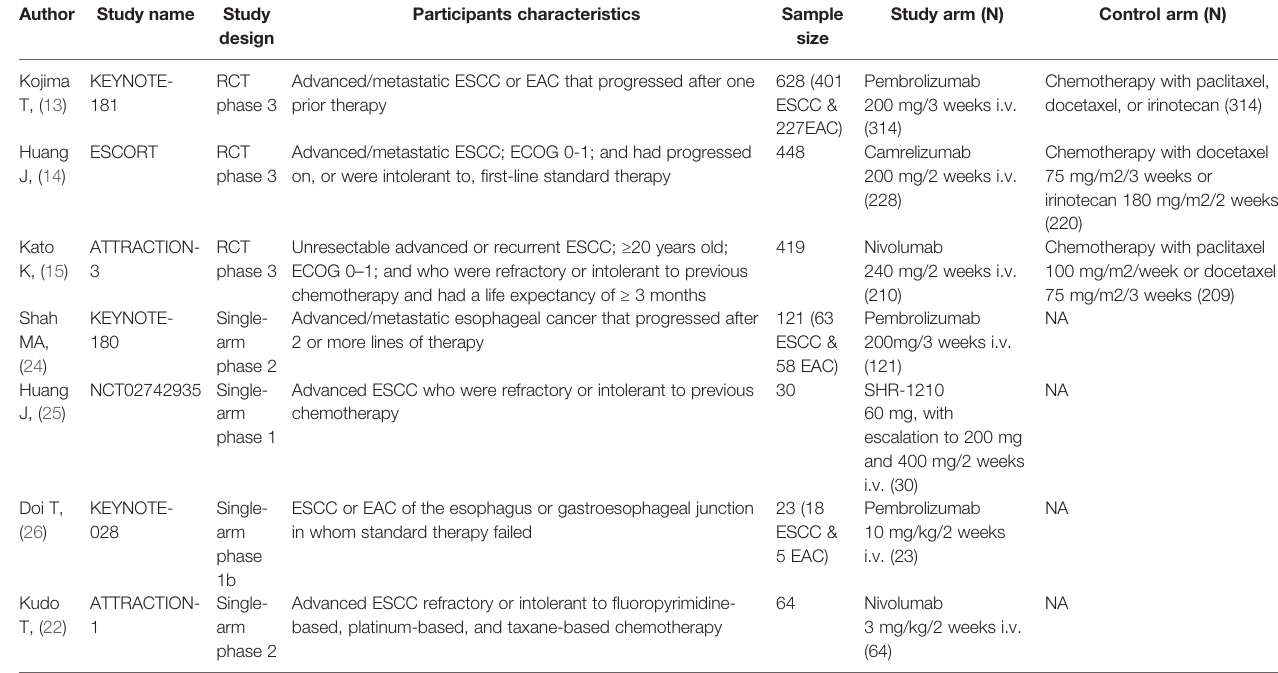
TABLE 1 | Baseline characteristics of included